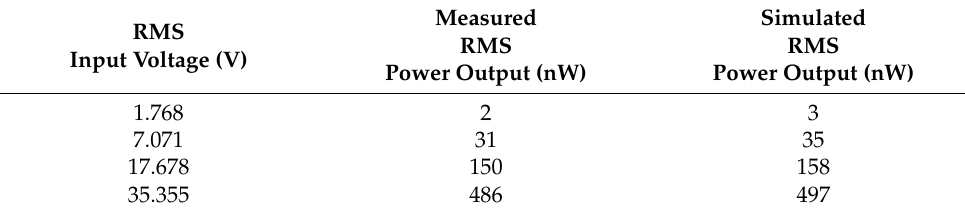
Table 4. Comparison between measured and simulated RMS power output